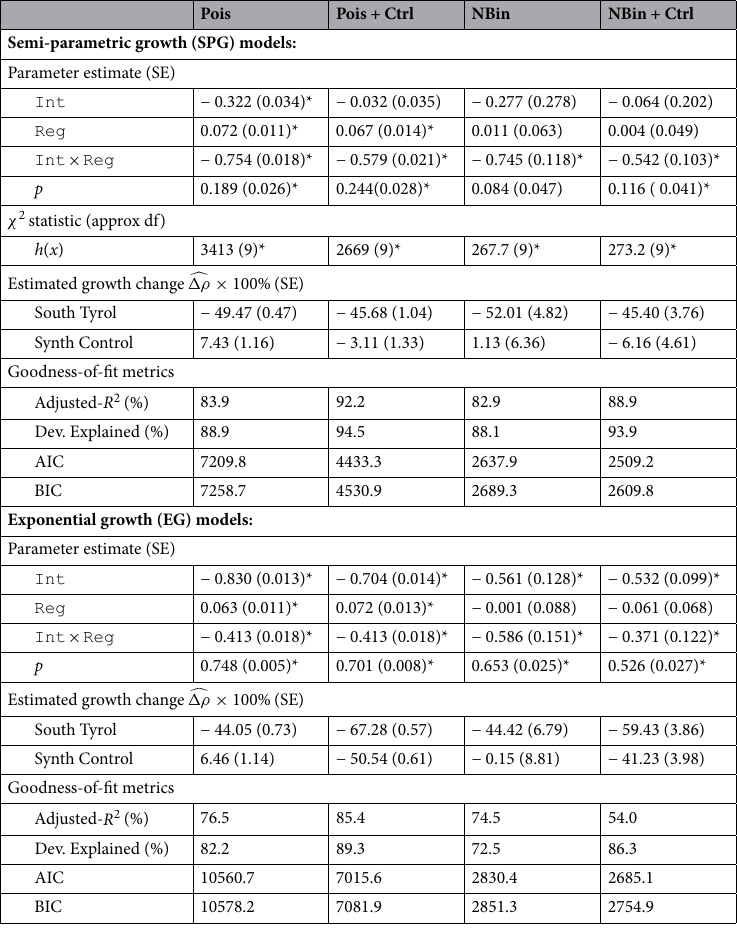
Table 1. Fitted semi-parametric growth (SPG) and exponential growth (EG) models Using Poisson (Pois) and negative binomial (NBin) response with additional control variables (+Ctrl) and without additional controls. For the parametric terms estimates are reported with standard errors in parenthesis. For the SPG models 2 the χ statistics corresponding to null hypothesis “ H 0 : h ( x ) = 0 ” are given with the approximate degrees of freedom (df). Significant results (p-value<0.01) are marked by “*”. For all the models we report estimated �ρ × 100% for South Tyrol and synthetic control groups as well as the percent relative growth change 2 following goodness-of-fit statistics: percent adjusted- R , percent deviance explained (Dev. Explained), Akaike (cid:31) Information criterion (AIC) and Bayesian Information Criterion